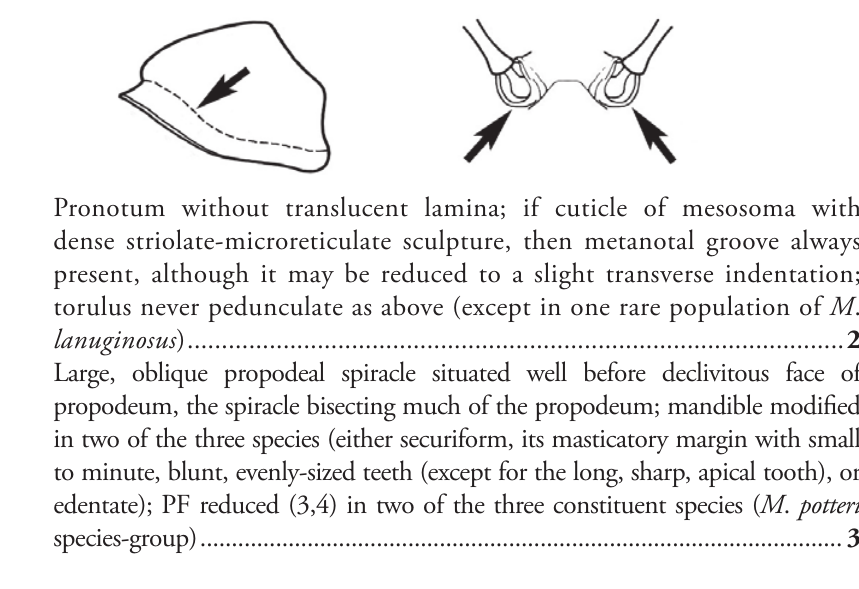
Pronotum surrounded by translucent lamina; metanotal groove obsolete in minor worker, a weak furrow in major worker; torulus pedunculate around antennal insertions; cuticle of mesosoma with dense striolate-microreticulate sculpture (eastern Australian seaboard) ( M . ludius species-group) ( M . hirsutus species-complex) (Fig. 91(a–h) ......................................................... hirsutus